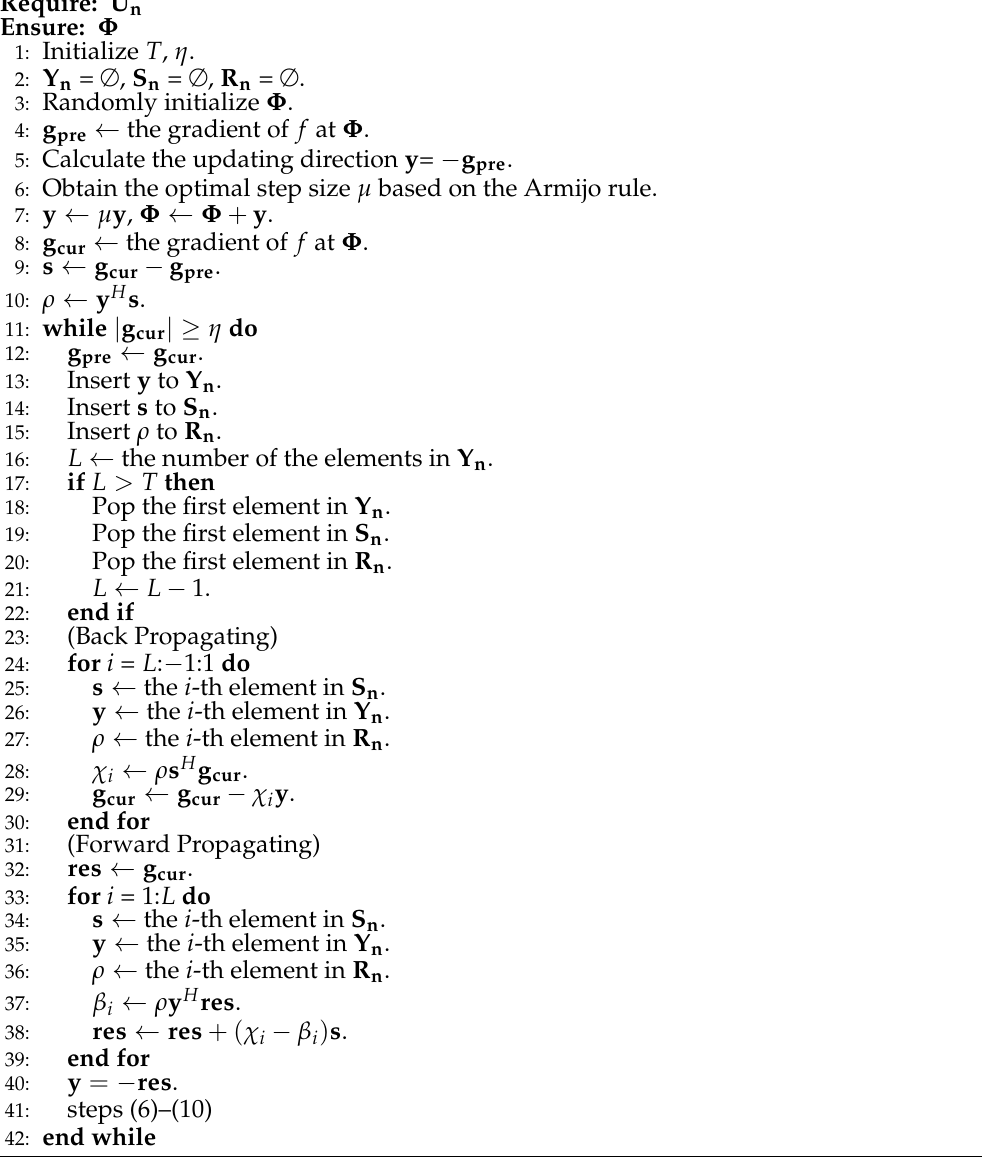
Algorithm 1 Beam-forming Algorithm for A Given